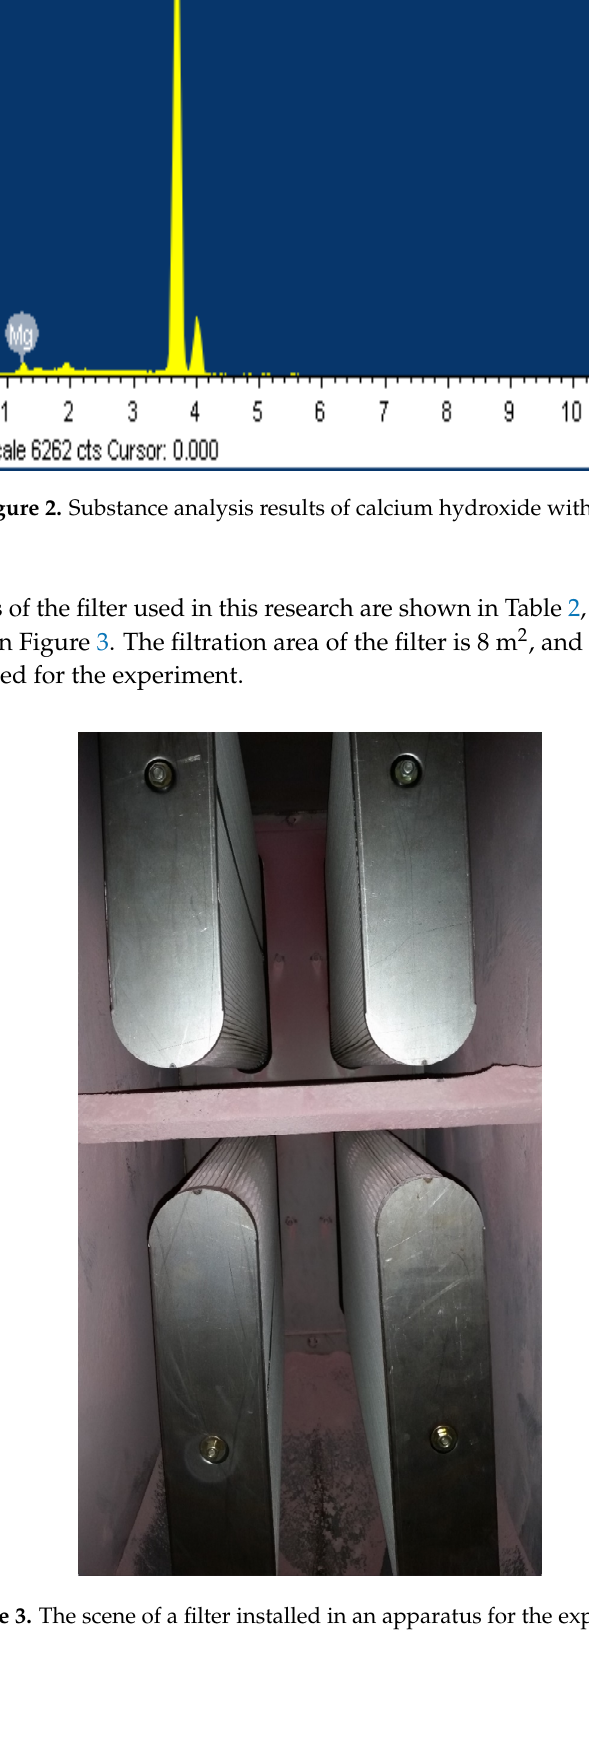
Figure 3. The scene of a filter installed in an apparatus for the experiment.